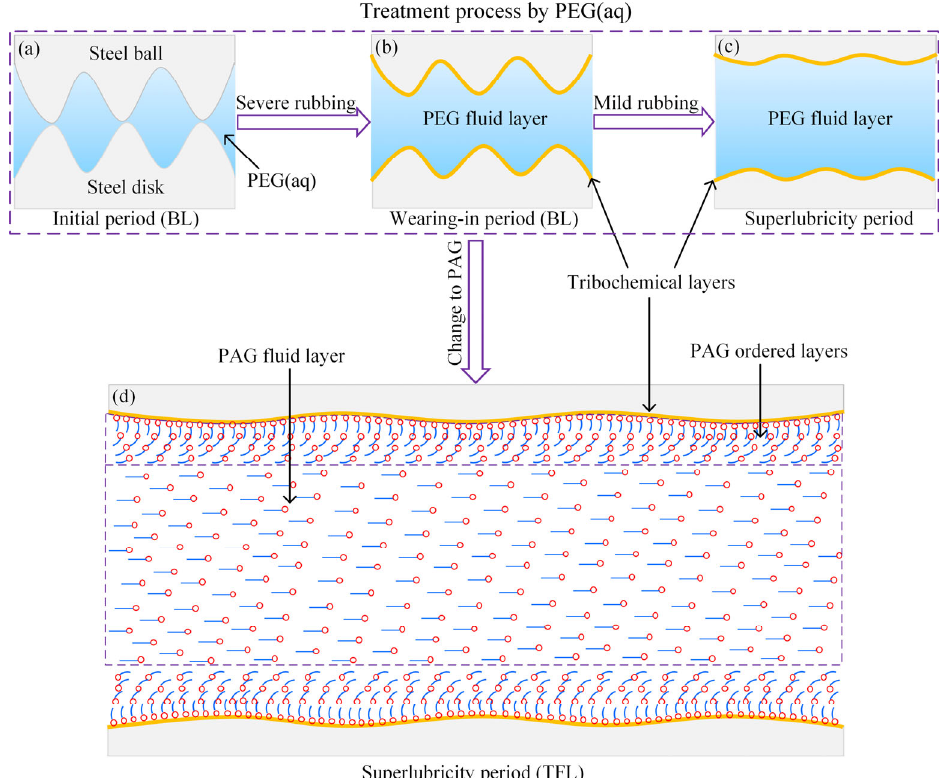
Fig. 5 Proposed superlubricity model in the TFL regime: (a) initial period in the BL regime lubricated with PEG(aq); (b) wearing-in period in the BL regime with PEG(aq) lubrication; (c) superlubricity period with PEG(aq) lubrication; and (d) superlubricity period in the TFL regime with PAG lubrication. (a) − (c) are the treatment processes of the steel/steel friction pairs by